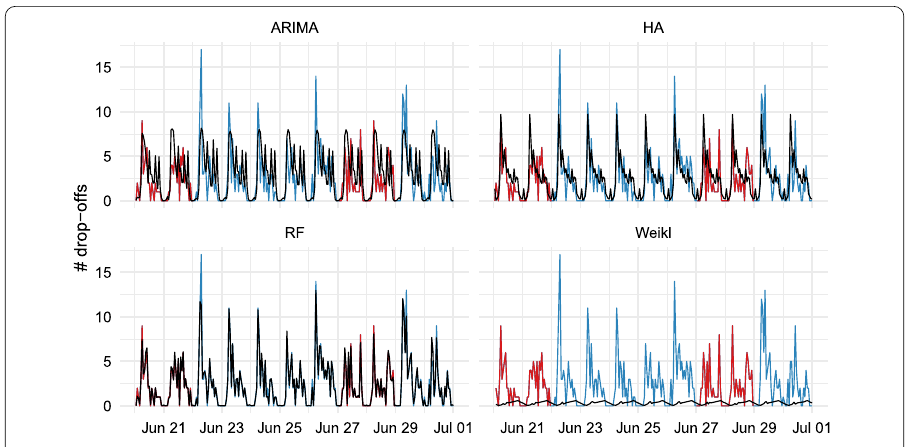
Figure 7 Time series of predicted vs observed drop-offs for a tagged cell. RMSE: 2.44 (ARIMA), 1.83 (HA), 1.72 (RF), 3.56 (WEIKL). Black is used for the predicted time series, while blue and red are for weekdays and weekends, respectively, of the test